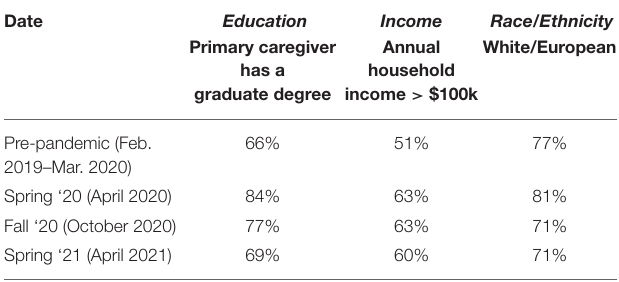
TABLE 1 | Quarterly summary of demographic